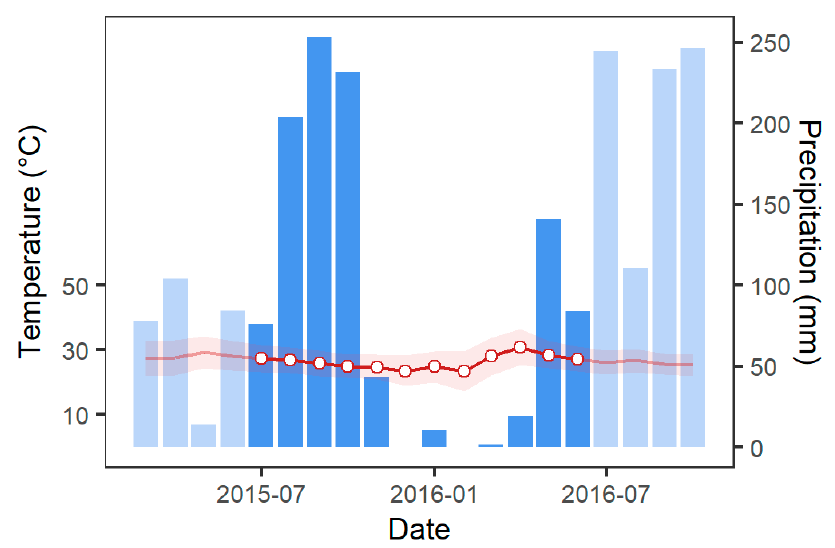
Figure 1. Climate chart of the study site based on measurements between January 2015 and December 2016. Darker bars and points correspond to times of soil respiration measurement.